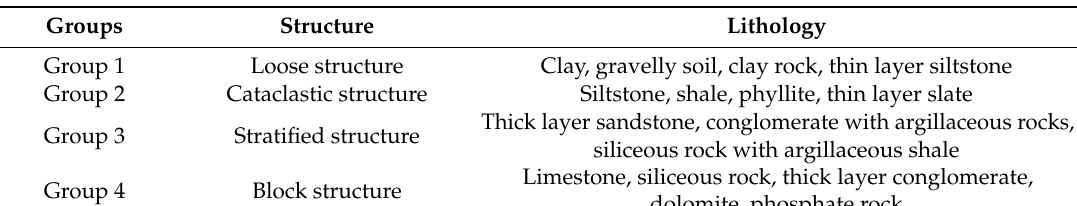
Table 2. Lithology and structure in the study area.